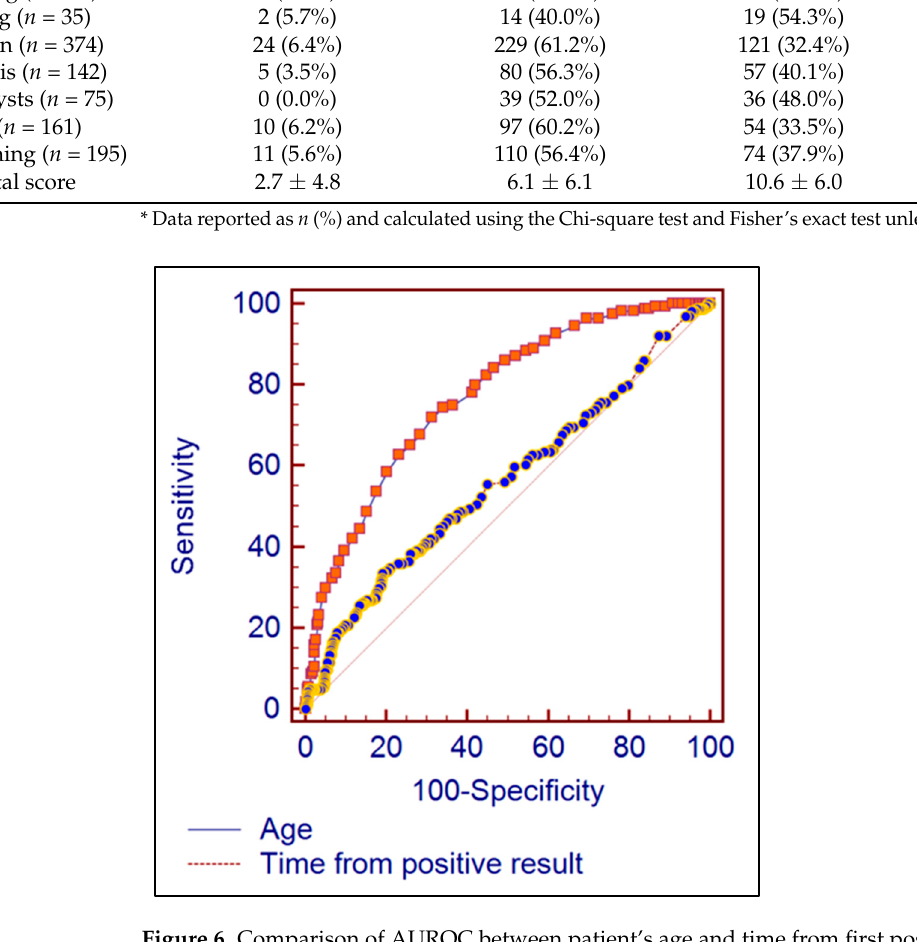
Figure 6. Comparison of AUROC between patient’s age and time from first positive COVID-19